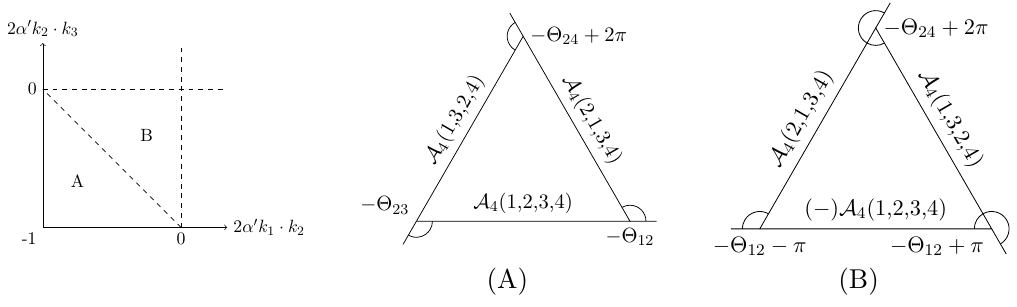
Figure 6. Plahte diagrams for four gluon scattering in the kinematic regions (A) and (B). plitude for four-point gluon scattering is well-known